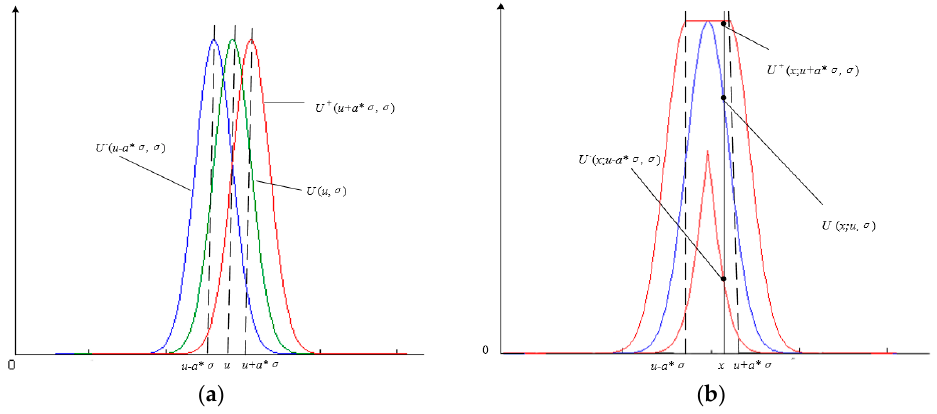
Figure 2. Interval type-2 fuzzy model with uncertain mean. ( a ) Type-1 fuzzy membership function with uncertainty of horizontal direction; and, ( b ) Interval Type-2 fuzzy membership function.